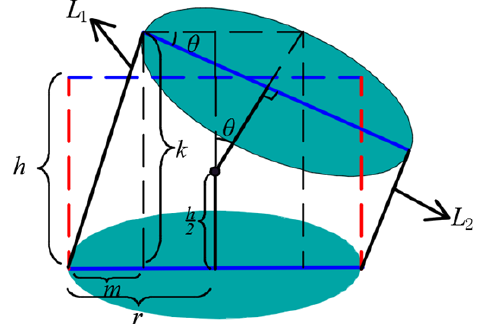
Figure 5. Single-joint